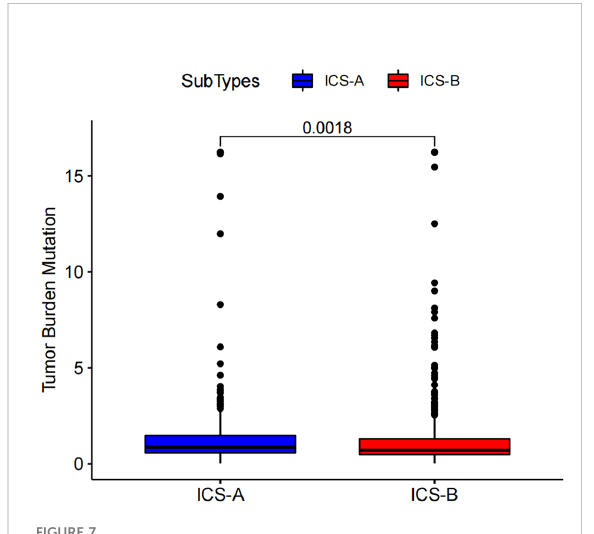
FIGURE 7 Tumor mutational burden (TMB) differences between the ICS-A and ICS-B subtypes. p-values were adjusted using FDR correction.